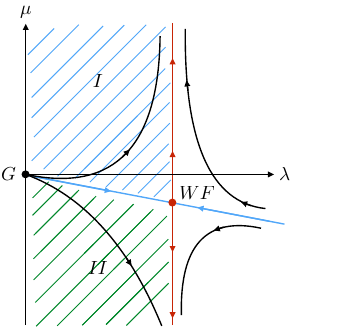
Figure 1. Left: Phase diagram of a local scalar field theory with quartic interaction on R 3 . The “mass parameter” is denoted by µ while the interaction couples with λ . G denotes the Gaussian fixed point and WF the Wilson-Fisher fixed point. In the region hatched in green (cid:104) ˆ ϕ (cid:105) (cid:54) = 0 holds. Right: Exemplary phase diagram of a quartic tensorial GFT on R d (cf. Refs. [48,49]). In the analogue of region II on the left-hand side, a non-vanishing expectation value of the field operator is expected to be